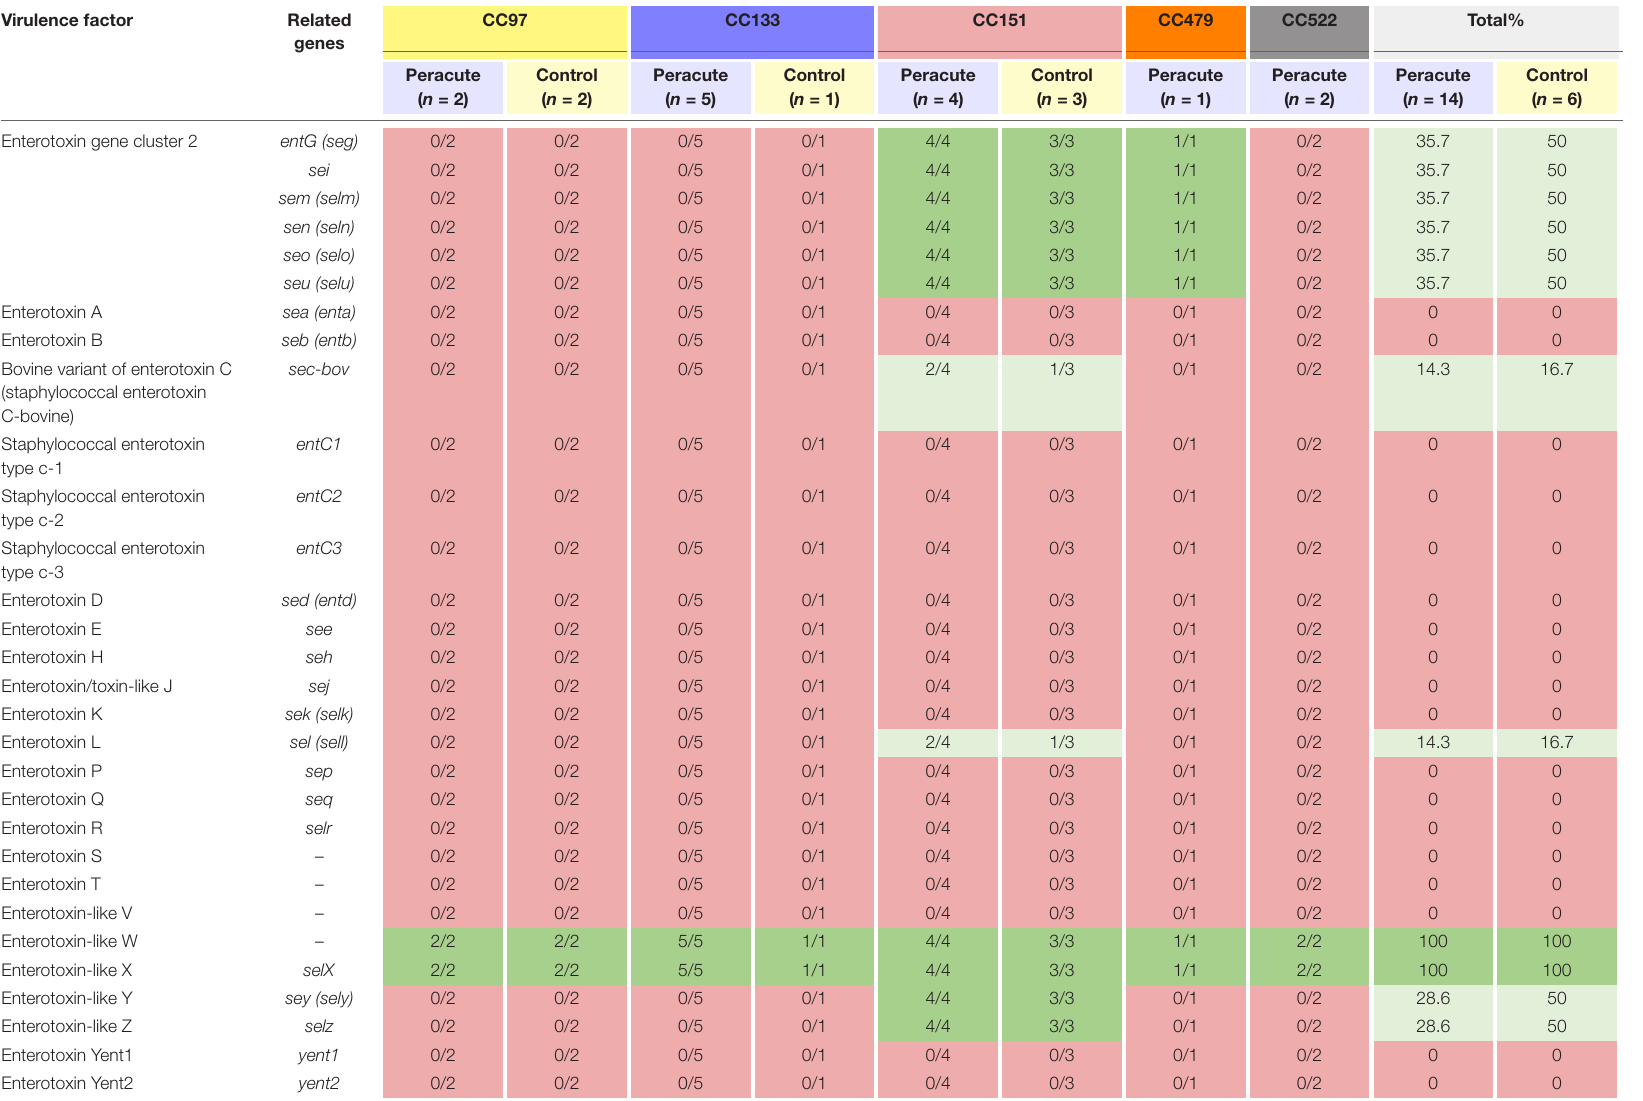
TABLE 4 | Distribution of enterotoxin and enterotoxin-like genes in 20 Staphylococcus aureus isolates from bovine mastitis milk samples classified by clonal complex (CC) and study